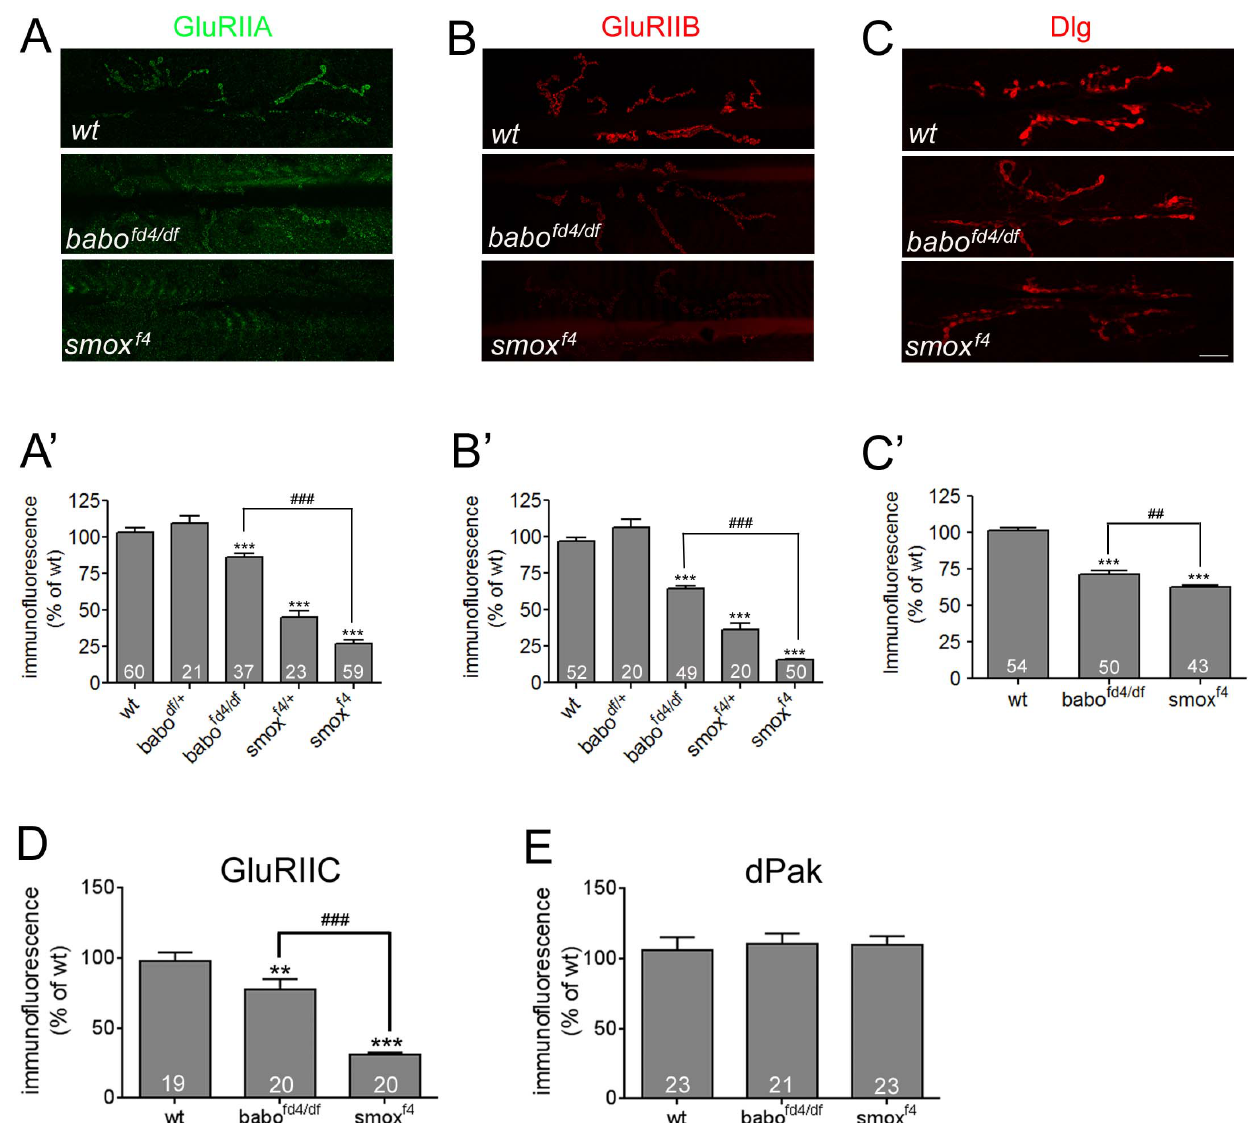
Figure 3. Postsynaptic densities of GluRIIA, GluRIIB and Dlg are decreased in Activin/TGF- b pathway mutants. (A andA’)Representative confocal images of the GluRIIA staining and quantification. The GluRIIA abundance is reduced greatly in smox f4 and slightly in babo fd4/df NMJs. (B and B 9 ) Representative confocal images of the GluRIIB staining and quantification shows decreased abundances in babo fd4/df and smox f4 NMJs. (C and C 9 ) Representative confocal images of Dlg staining and quantification. The Dlg level is also decreased in the babo and smox mutants. (D) Quantification of synaptic GluRIIC abundancein wild-type and babo and smox mutants. (E) Quantification of dPak stainingreveals no difference between wild-type and Activin/TGF- b pathway mutants. Error bars represent SEM. *p , 0.05, **p , 0.01, ***p , 0.001 from One-way ANOVA followed by Dunnett’s multiple comparison test. ## p , 0.01, ### p , 0.001 from unpaired t-test. Each genotype was compared to wild-type. Additionally, smox f4 was also compared to babo fd4/df in A 9 , B 9 , C 9 and D as indicated by lines. Scale bar equals 20 m m. expression and assessed the densities of Dlg at the synapses. The expression of RNAi transgenes, however, did not result in an increase in synaptic Dlg levels (data not shown). In an accompanying experiment, we expressed Ala, a pseudo-substrate of CaMKII, to inhibit the activity of CaMKII in smox null animals, but this treatment also failed to increase the synaptic Dlg level. Finally, we detected no change in PAR-1 protein level in babo and smox mutants by Western blot analysis (data not shown). It has been shown that a cascade of molecules involving Drosophila p21-activated kinase (dPak) act as postsynaptic signaling/scaffold proteins in parallel with Dlg-mediated protein localization [44].